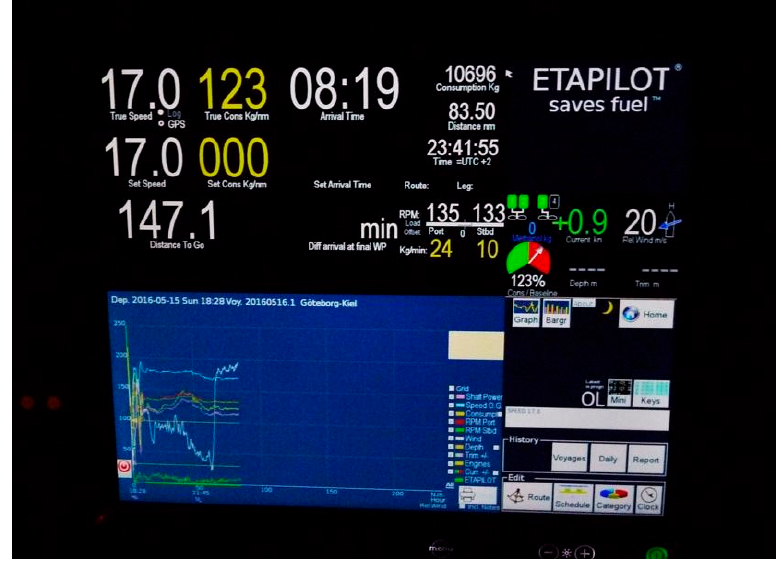
Figure 2. The true speed (17 knots/h), the fuel burning rate (123 kg/nautical mile), as well as total fuel consumption (10,696 kg) were displayed on the user interface of the ETA-pilot.